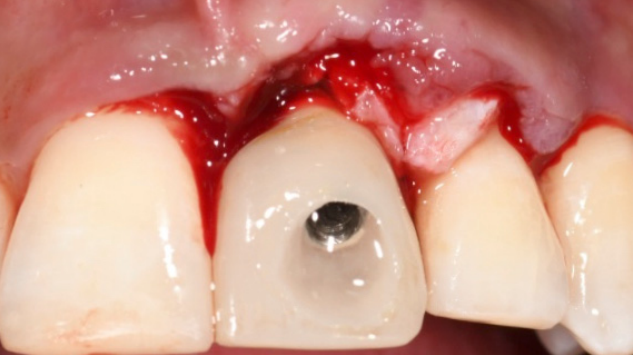
Figure 14. Six months after implant placement, CTG placed over the recipient site.